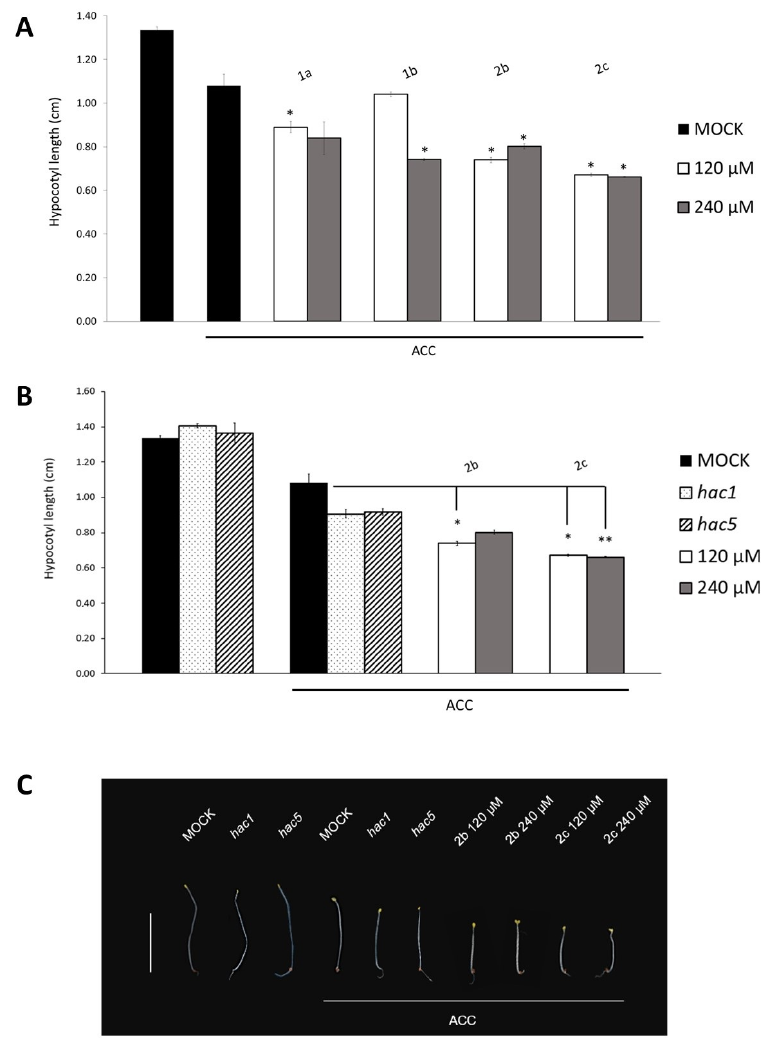
Figure 5. HAC inhibitors result in stronger phenotypes of hac mutants, in the presence of ACC. ( A ) The hypocotyl length of wild type 6-day-old seedlings untreated, or treated with the selected compounds 1b , 2b , 2c and 1a (120 and 240 µ M), in the presence of ACC (10 µ M), compared to the DMSO-treated control (MOCK). ( B ) The hypocotyl length of untreated (no ACC) or treated (+ACC) wild type, hac1 and hac5 single mutants compared to the 2b - and 2c -treated wild type (+ACC). ( C ) Six-day-old dark-grown untreated (no ACC) or treated (+ ACC) wild type, hac1 and hac5 single mutants compared to the 2b - and 2c -treated wild type (+ ACC). Scale bar, 1 cm. The values of the hypocotyl length are the mean of two biological replicates (50 seedling each) presented with SD values. Significant differences from the mock were analyzed by t -test (* p ≤ 0.01; ** p ≤